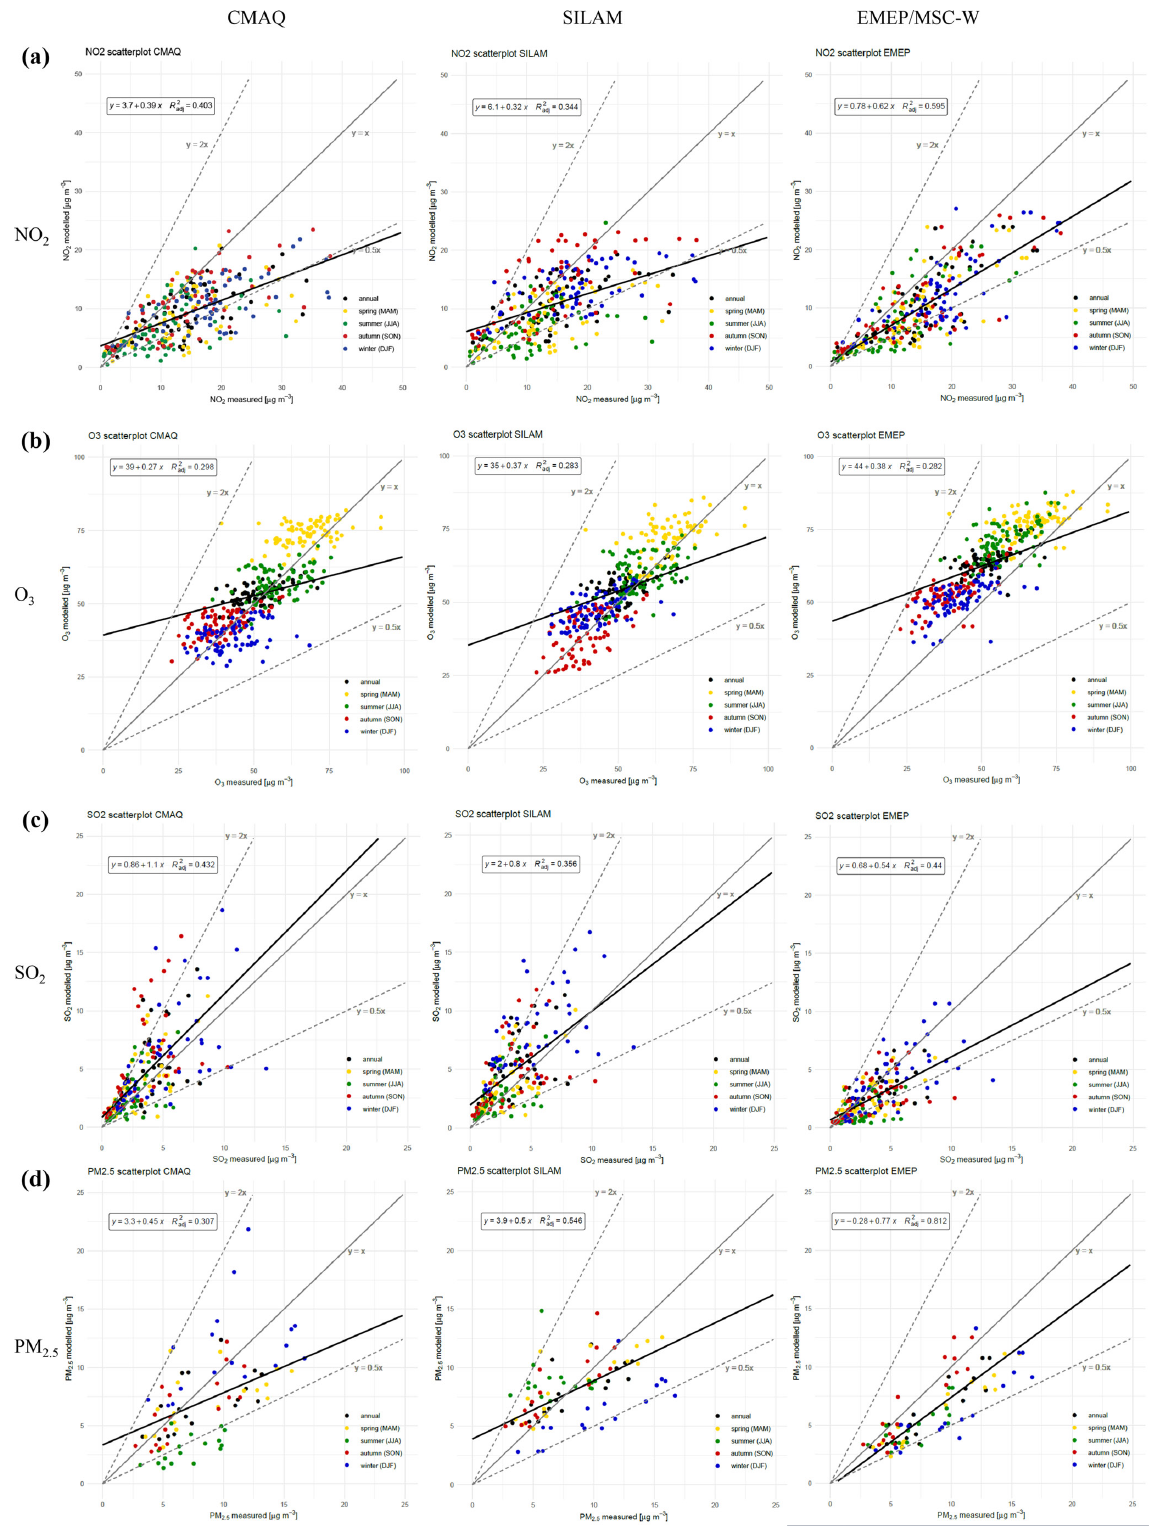
Figure 7. Spatial correlation of annual mean concentrations (µgm − 3 ) and the seasonal averages from CMAQ (left column), SILAM (middle column) and EMEP (right column) in the Baltic Sea region for (a) O 3 , (b) NO 2 , (c) SO 2 and (d) PM 2 . 5